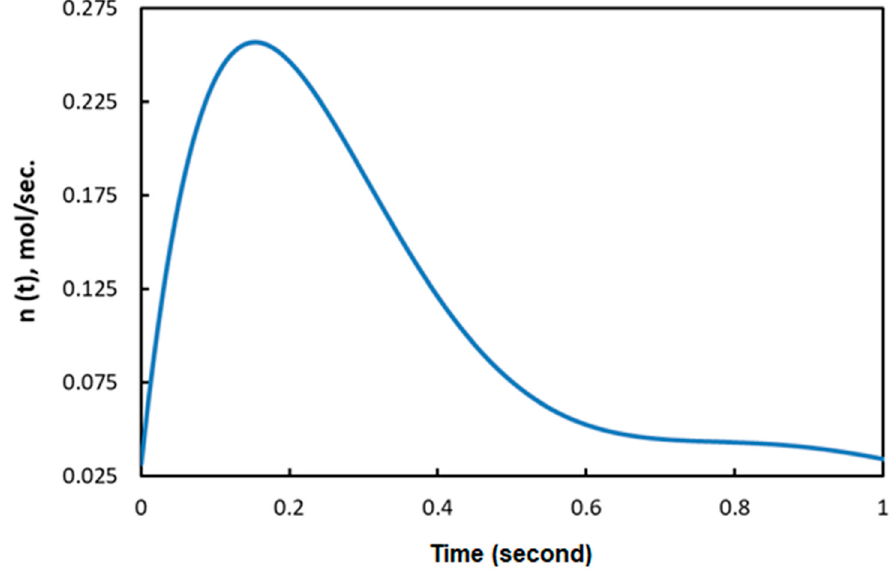
Figure 9. Airflow versus time.